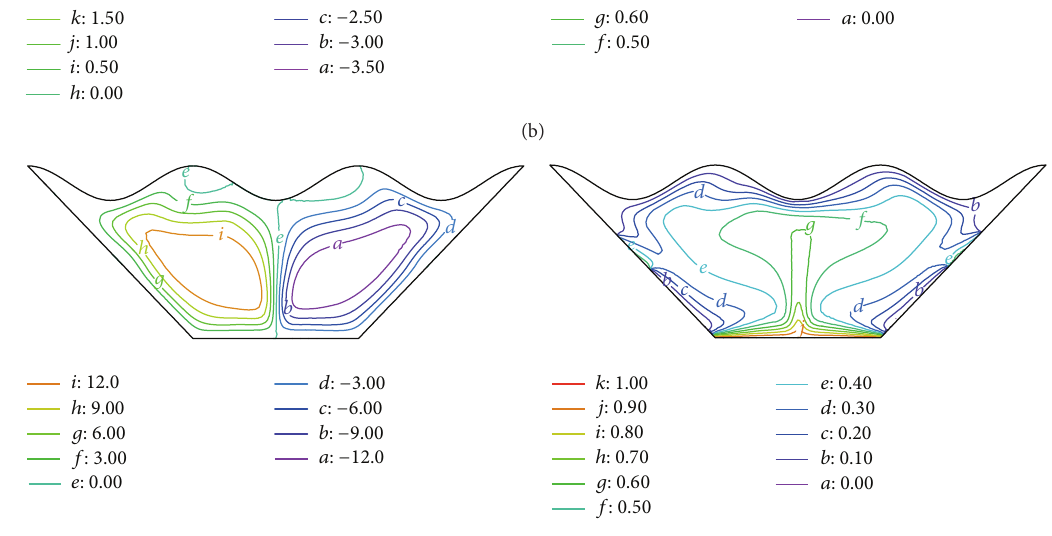
entire enclosure compared to the case of Da = 10 −5 . The influence of convection resulting in stronger fluid intensity and larger temperature distribution can be observed when Da is increased to 10 −3 . In addition, fluid circulation is stronger and temperature distribution becomes larger when Ra is increased with constant Da or Da is increased with constant Ra. Note that the intensity of flow circulation and temperature distribution depend on Ra and Da in which the range of these values has an important role to define the conduction and convection dominant.